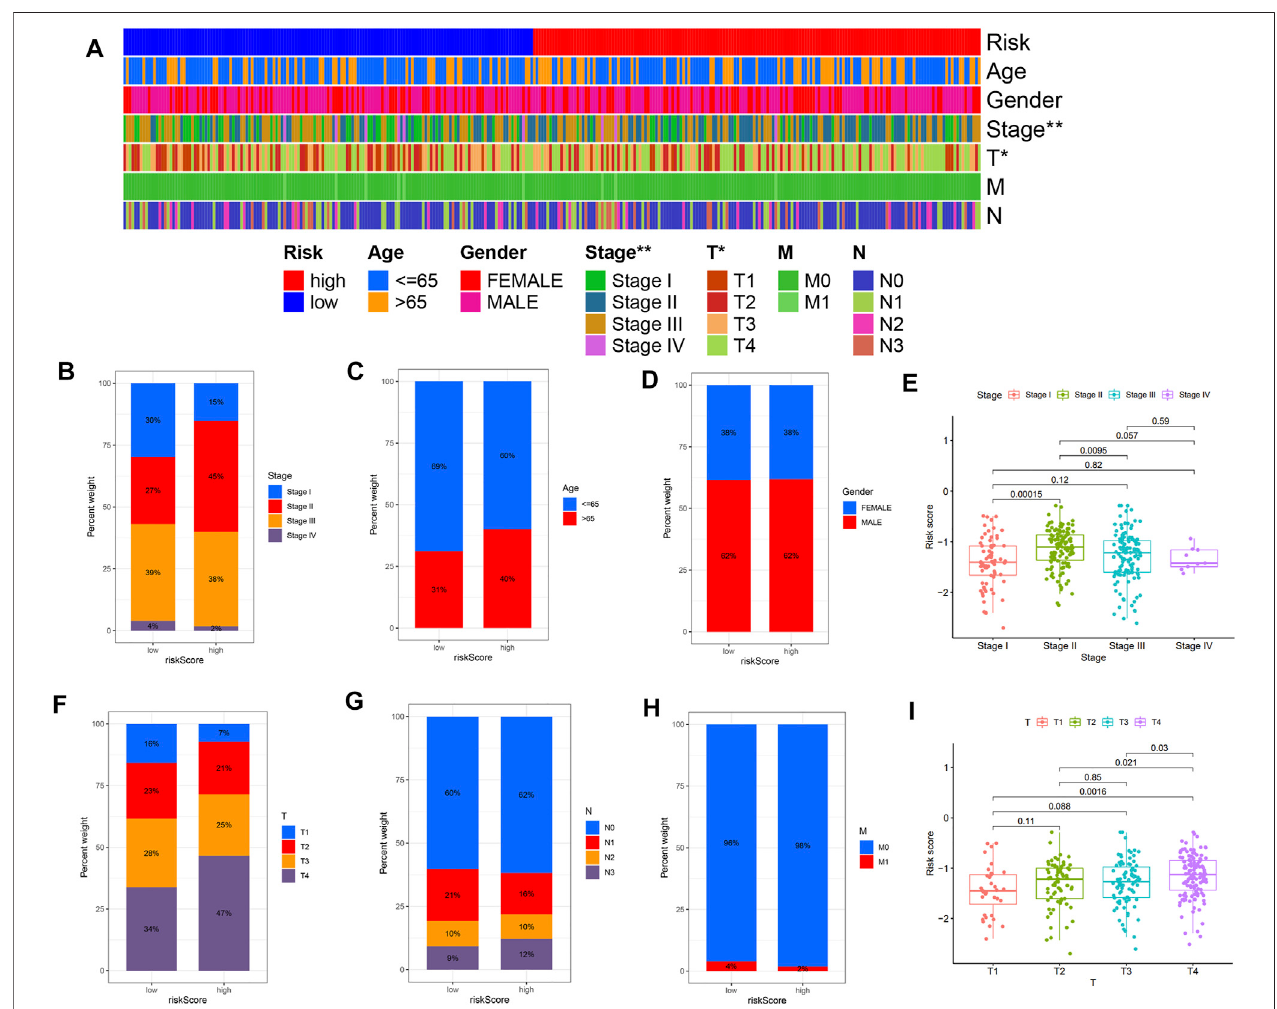
FIGURE5| Theriskscoreandclinicopathologicalcharacteristics ’ correlation. (A) Theheatmapshowstheclinicopathologicalfeaturesdistributionbetweenthetwo risksubgroups. (B) Riskscoredistributionstrati fi edby (B) tumorstage, (C) age, (D) gender, (F) Tstage, (G) Nstage,and (H) Mstage. (E,I) Thedistributionofriskscores according to tumor stage and T stage. * p < 0.05, ** p < 0.01 and *** p < 0.001.